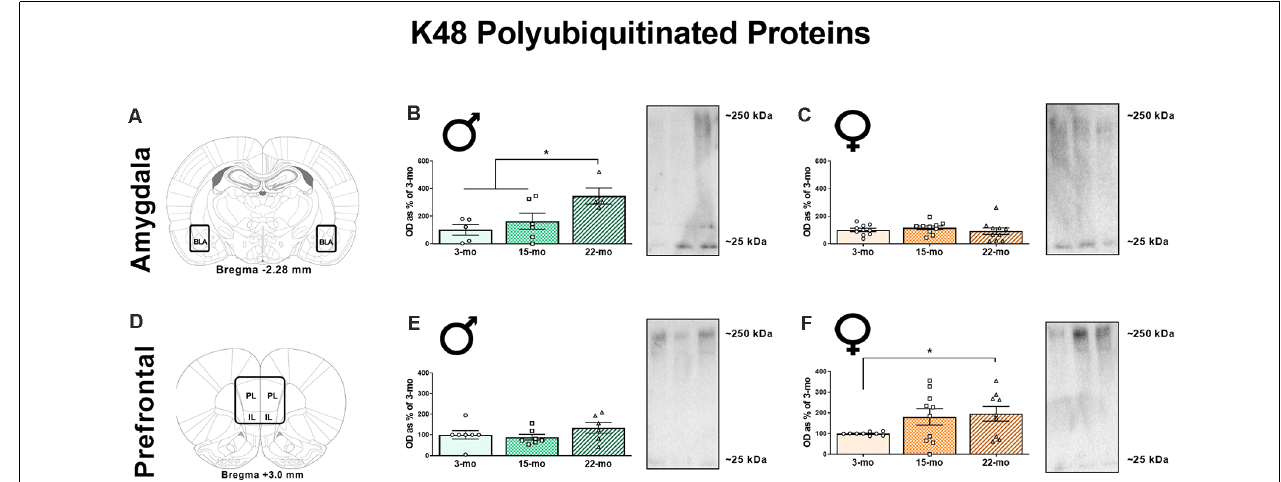
FIGURE 3 | Synaptic fractions were also used to analyze the accumulation of K48-linked polyubiquitination using western blots. In the BLA (A) , 22-mo old males display increased K48 (B) , while females show no such accumulation (C) . However, in the mPFC (D) , males show no differences in K48 (E) , but females 22-mo old females display increased accumulation of K48 (F) . Results are expressed as mean percentages of 3-mo old rats within each sex ( ± SEM). Blots have been cropped for clarity to show representative samples. The mPFC is defined as the area including both the prelimbic cortex (PL) and infralimbic cortex (IL). *Indicates P < 0.05.